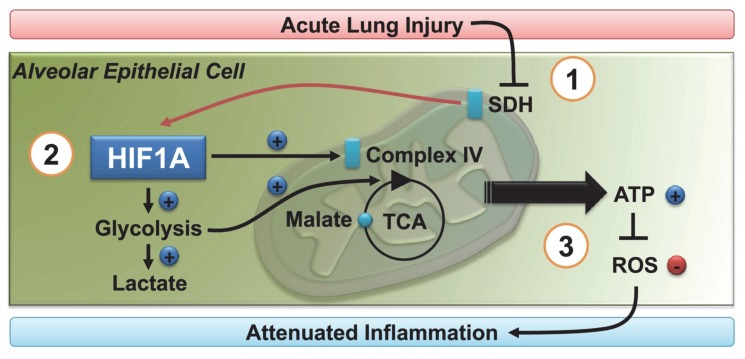
Proposed model of ALI-associated HIF1A stabilization.(1) During ALI, stretch of pulmonary epithelial cells results in the inhibition of succinate dehydrogenase (SDH), leading to normoxic stabilization of alveolar epithelial HIF1A. (2) Alveolar epithelial HIF1A results in increased glycolytic capacity, TCA flux, and optimized mitochondrial respiration via induction of Complex IV. (3) HIF1A-dependent prevention of mitochondrial dysfunction during ALI is associated with increased alveolar epithelial capacity to produce ATP, while concomitantly preventing ROS accumulation and attenuating lung inflammation.